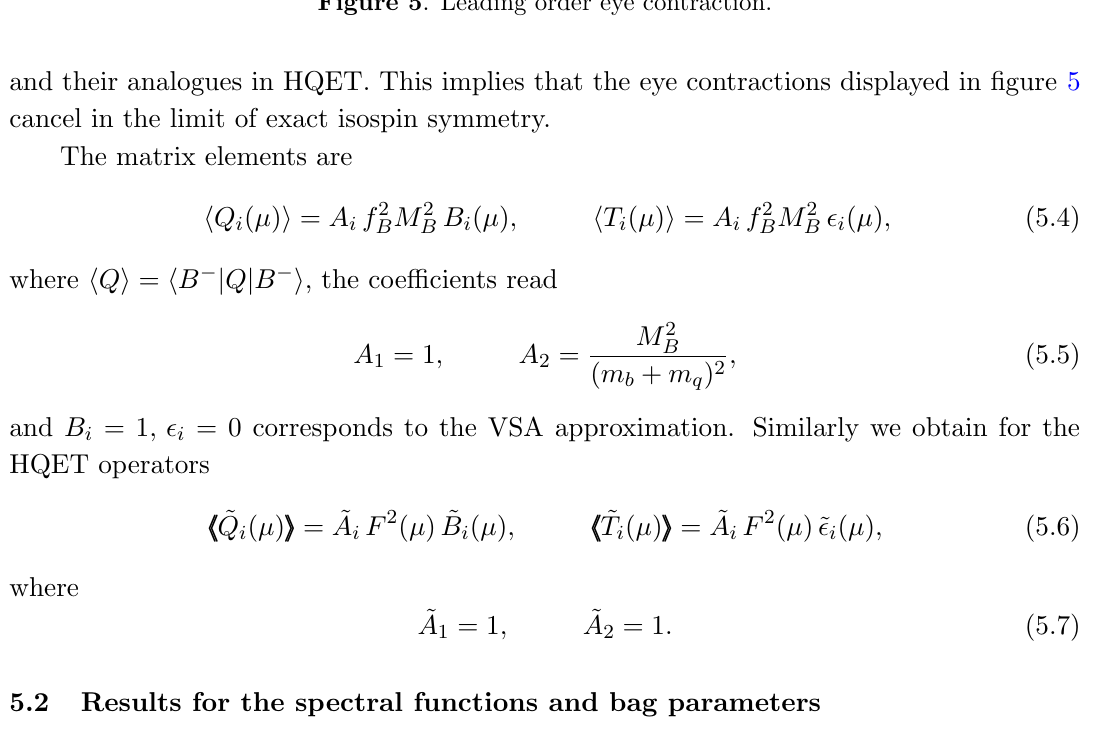
Figure 5 . Leading order eye